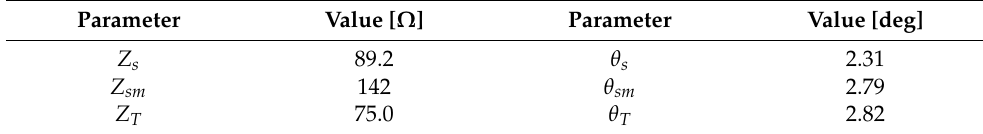
Table 2. Calculated electrical parameters for the proposed BPF.